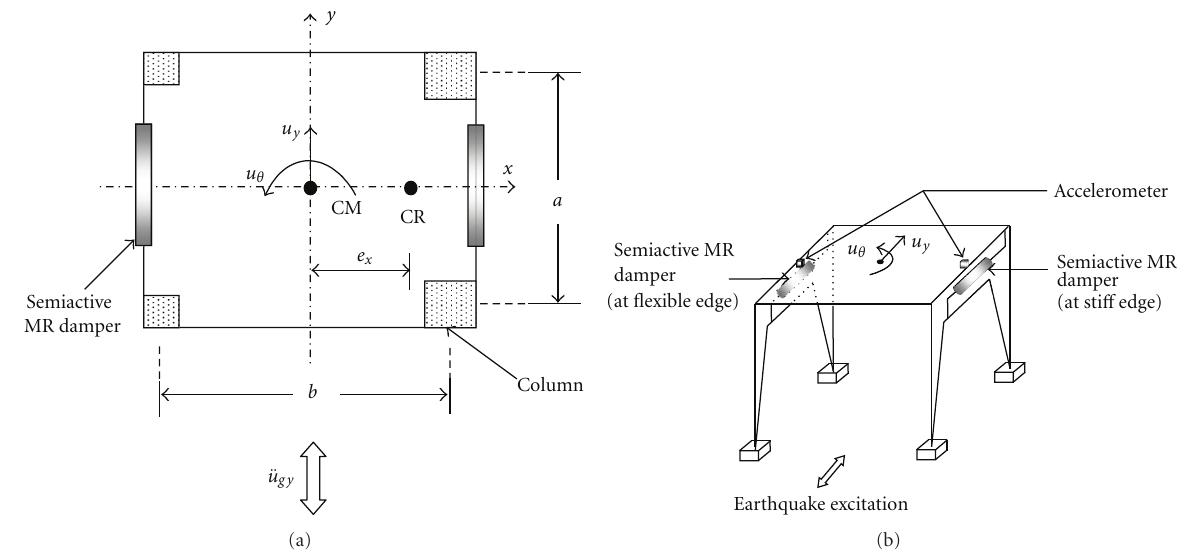
Figure 2: Plan and isometric view of one-way asymmetric system showing arrangement of dampers and accelerometers.